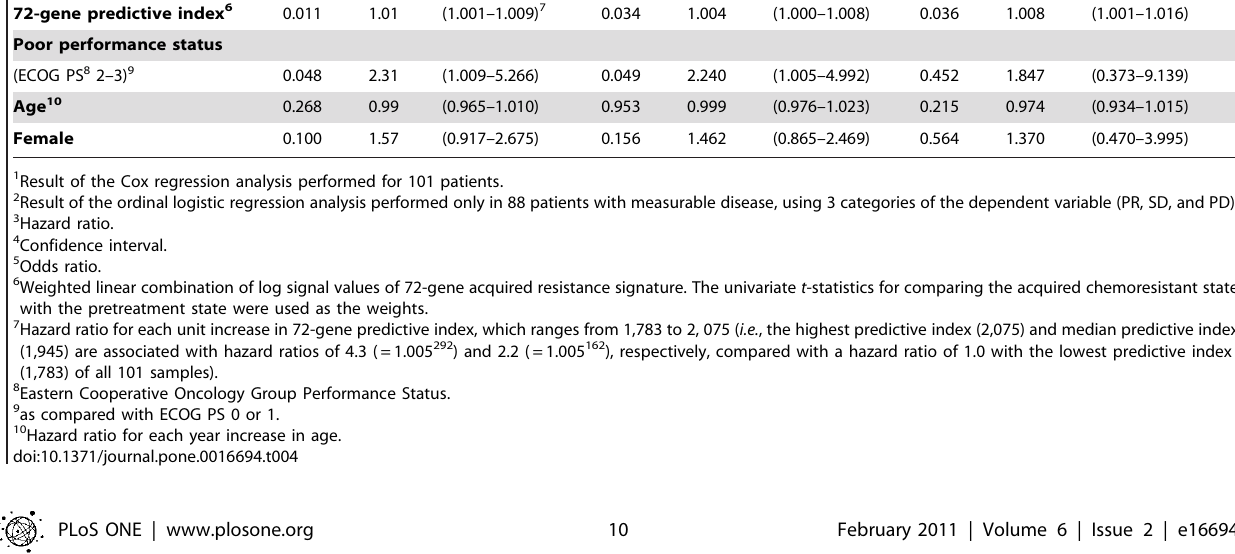
Table 4. Multivariable Regression Analyses of the 72-gene Predictive Index in 101 Separate (Non-rebiopsied) Gastric Cancer Patients.